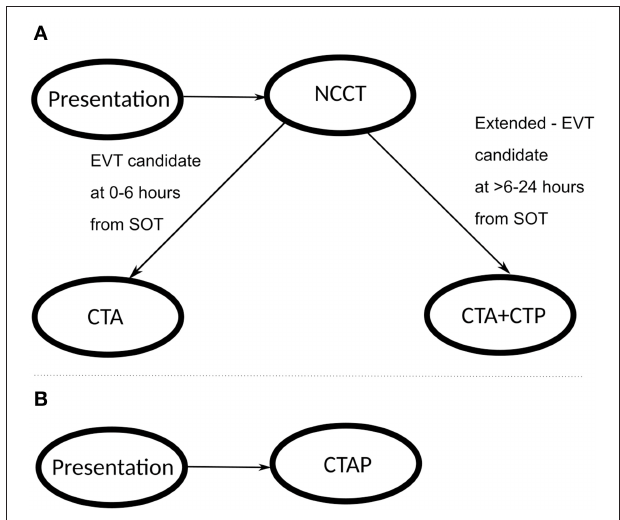
FIGURE 1 | Patient workflow through the stroke imaging pathway; (A) represents the standard-of-care pathway, and (B) represents the advanced CTAP imaging pathway.